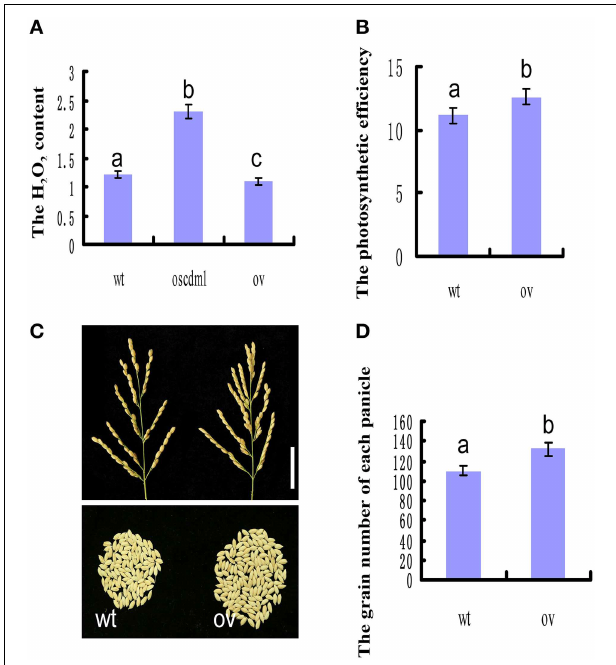
FIGURE 10 | OsSHMT1-OV plants exhibited improved photosynthetic efficiency and productivity. (A) The H 2 O 2 contents were measured among wild-type, oscdm1 mutant, and OsSHMT1-OV plants at the fourth leaf stage. (B) The photosynthetic efficiency was measured between wild-type and OsSHMT1-OV plants at the mature stage. (C) Comparison of wild-type and OsSHMT1-OV panicles. (D) Comparison of the grain number per panicle between wild-type and OsSHMT1-OV panicles. The data are the means ± SD ( n = 5 ). These experiments were repeated more than three times with similar results. Data were compared by one-way analysis of variance and Duncan’s multiple range test. Different letters (a–c) indicate significant differences (P, 0.05) between lines.